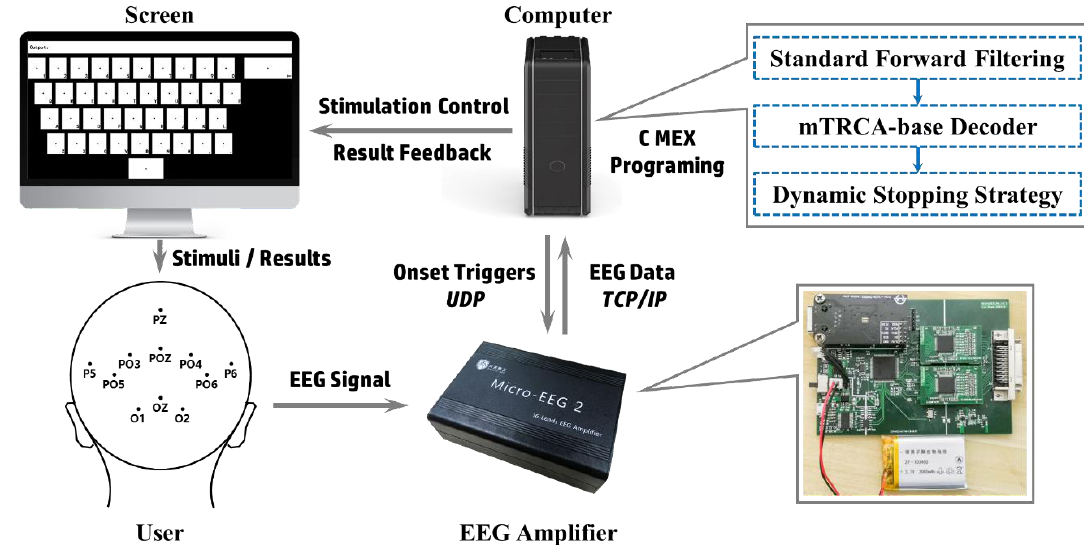
Figure 1. Overview of the system framework. The stimulation was controlled by a computer, and the electroencephalogram (EEGs) were acquired by a self-developed EEG amplifier. The stimulus onset triggers and the EEG data were sent and received with user datagram protocol (UDP) and transmission control protocol/internet protocol (TCP/IP), respectively. The EEG data were decoded by the computer and the results were presented on the screen. The lower right is the circuit board of the EEG amplifier, and the upper right shows the innovation of the EEG decoding.